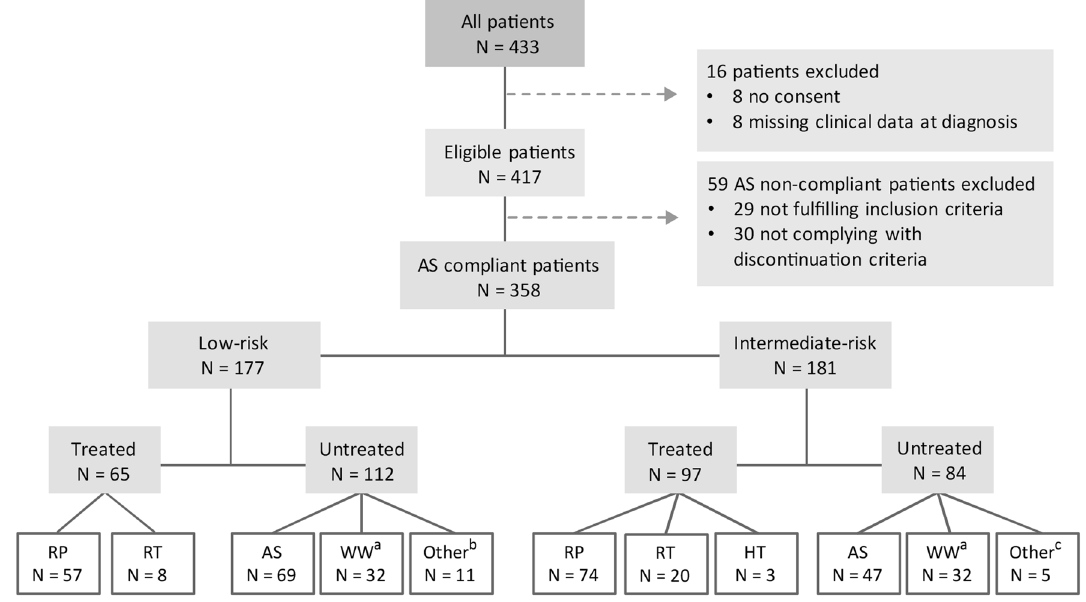
Figure 1. CONSORT diagram for the Vestfold Hospital Trust active surveillance program. AS active surveillance, HT hormonal therapy, RP radical prostatectomy, RT radiotherapy, WW watchful waiting. a Four intermediate-risk patients and two low-risk patients had disease reclassification but were transferred to WW due to low life expectancy; b Nine patients were lost to follow-up and two died; c Four patients were lost to follow-up and one